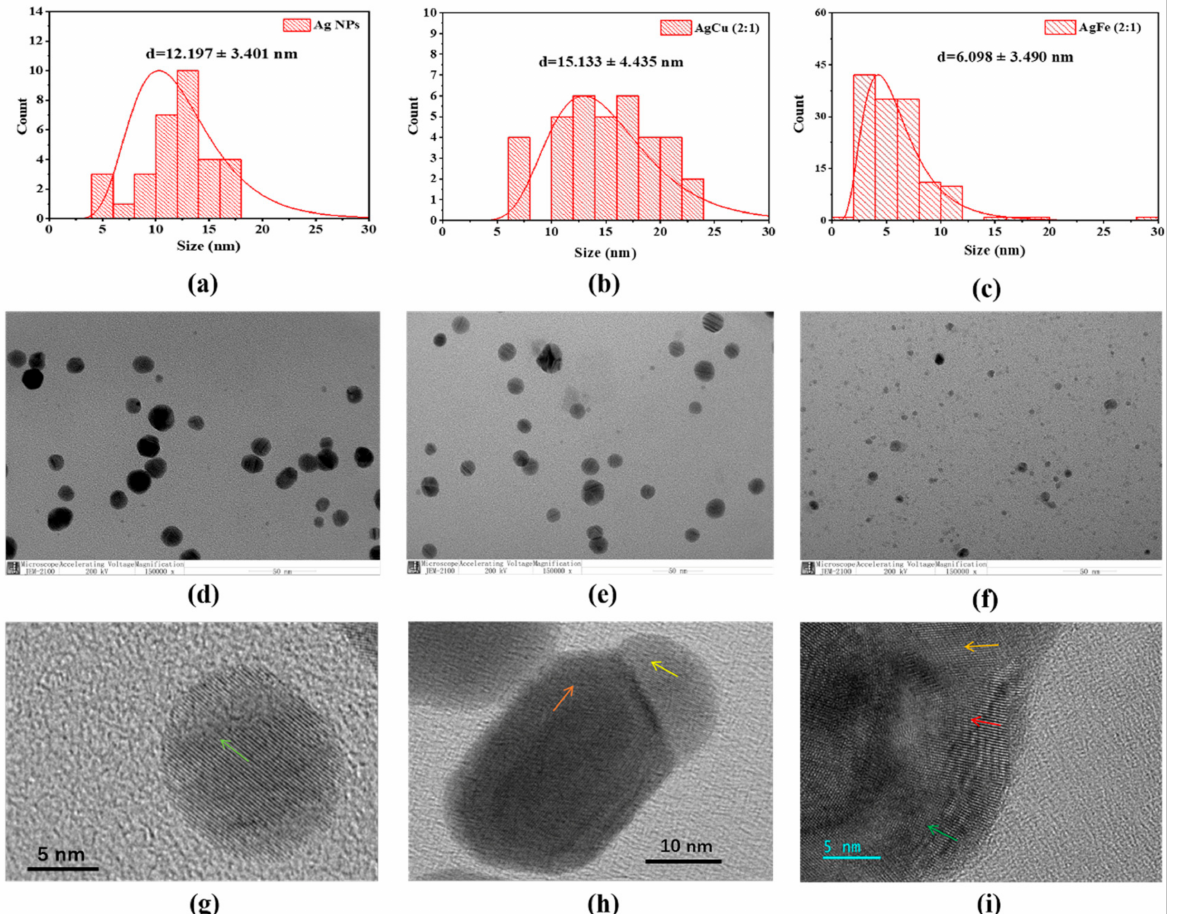
Figure 4. Size distributions and TEM photomicrographs of ( a , d , g ) Ag, ( b , e , h ) AgCu and ( c , f , i ) AgFe NAs. The arrows indicate local atomic lattice